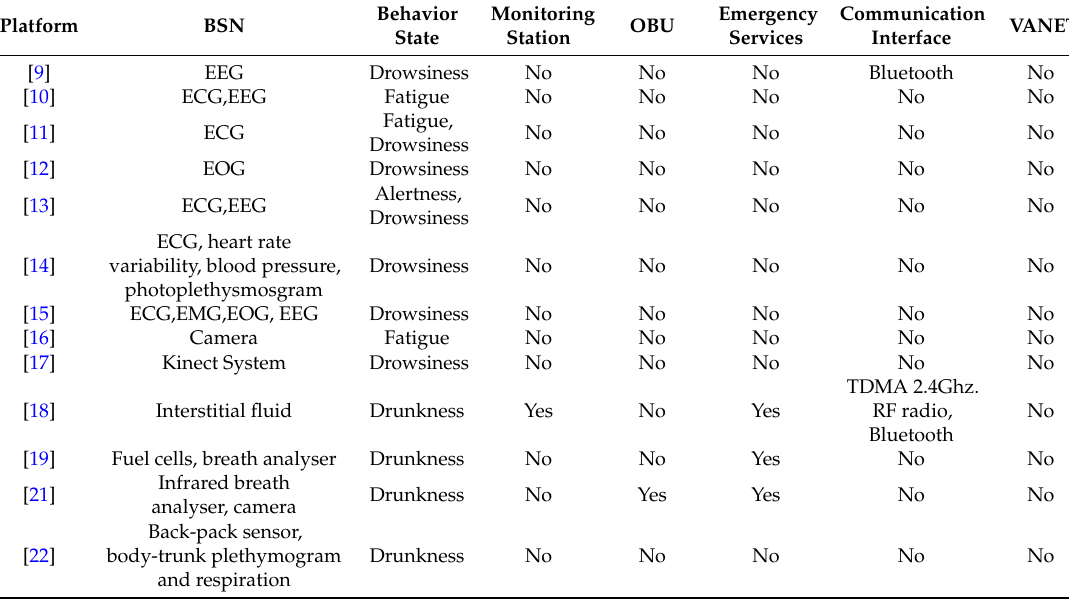
Table 2. Comparison of platform features offered by the current literature developments.